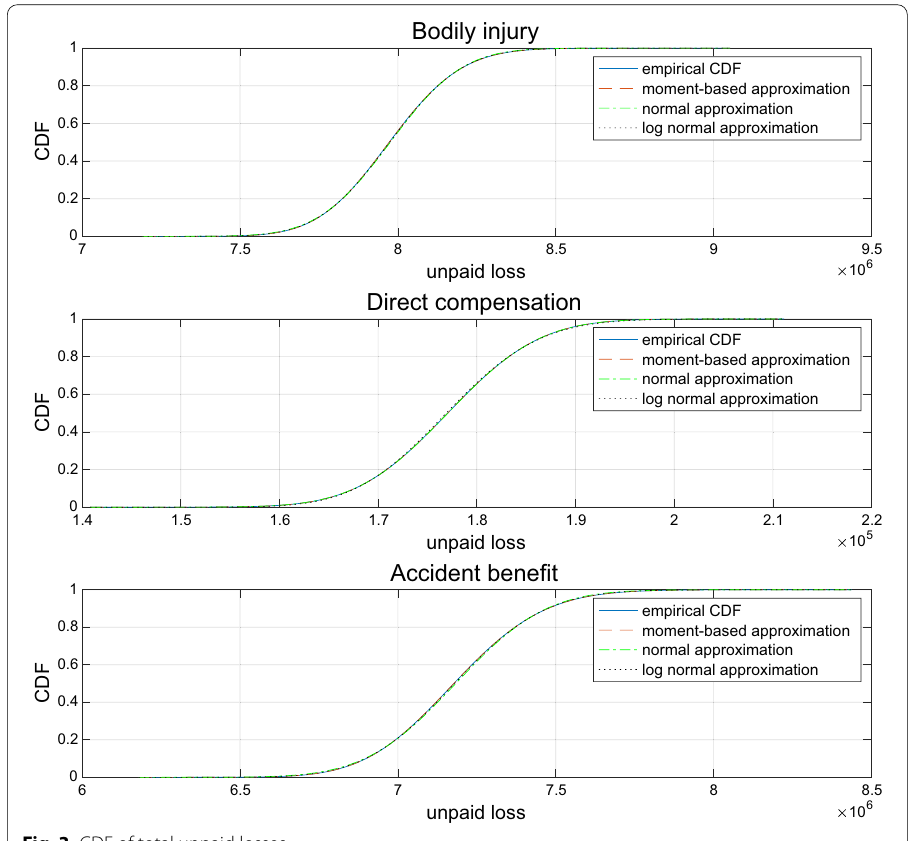
Fig. 3 CDF of total unpaid